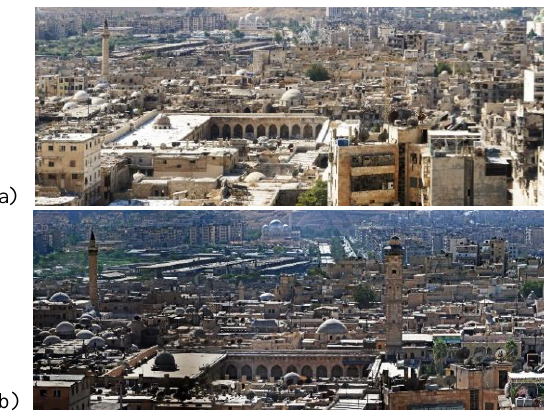
Figure 11. The Omayyadid’s Great Mosque, current situation (a) and how it was in 2010